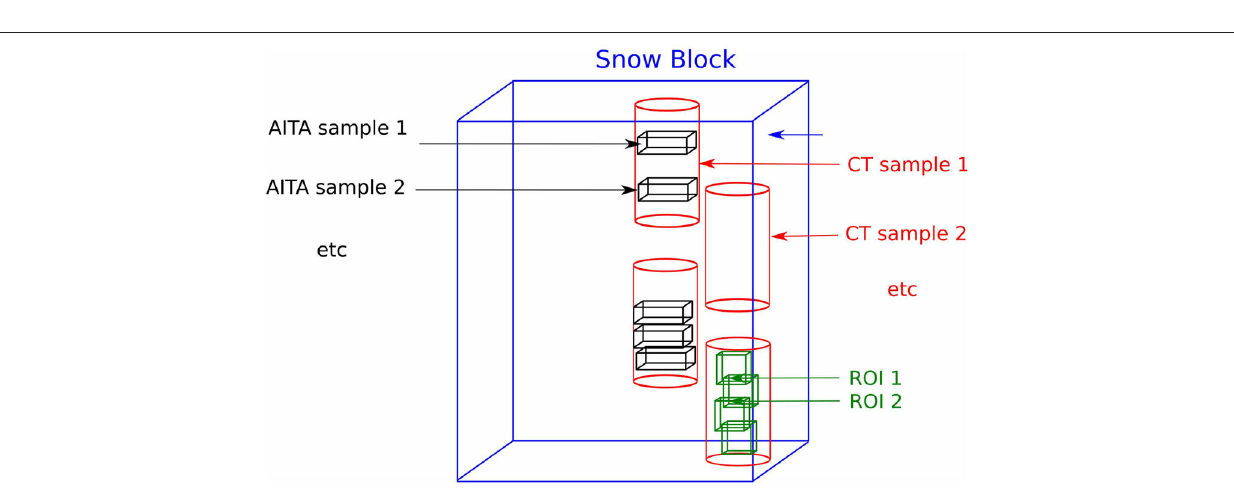
FIGURE 3 | Schematic showing the sub-sampling of the snow blocks for co-located microCT and AITA measurements. Typical dimensions of thin sections (from AITA samples) are 30 × 20 mm 2 . MicroCT samples are about 60 mm height and 30 mm